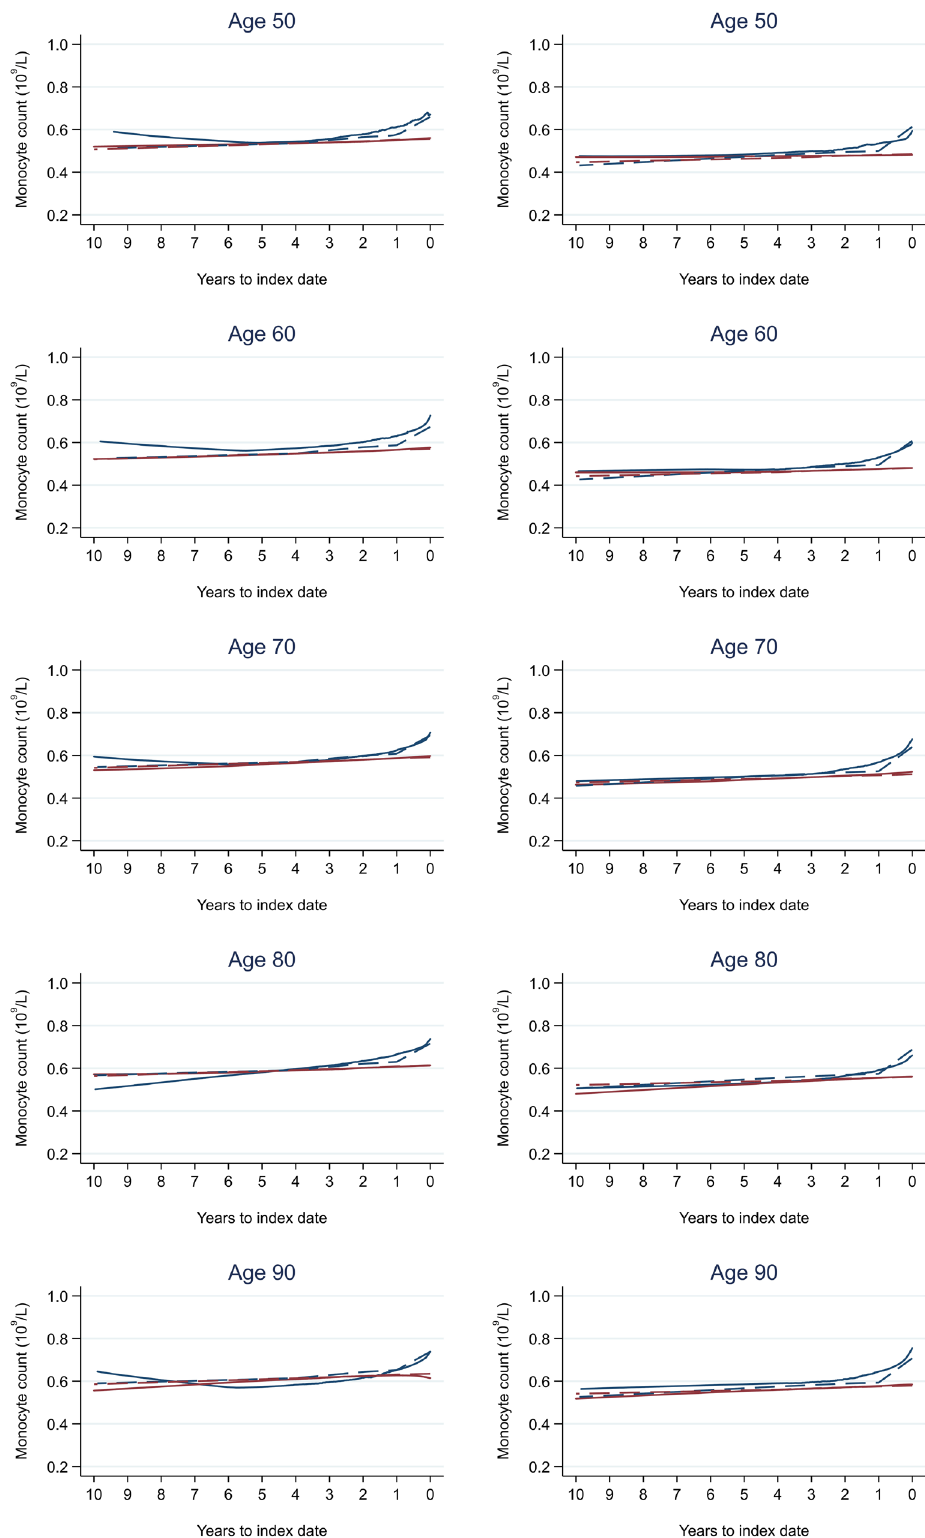
Figure 16. Monocyte count trends between cases and controls, by age at index date 1,2 . 1 Index date was the date of diagnosis for cases and a randomly selected date in the patient’s study period for controls. 2 LOWESS trends are age (+/- 3 years) and modelled (fixed effects) trends are taken at that specific age. Legend: males (left) and females (right). Colorectal cancer (blue line) and no cancer (red line). LOWESS trend (solid line) and modelled trend (dashed